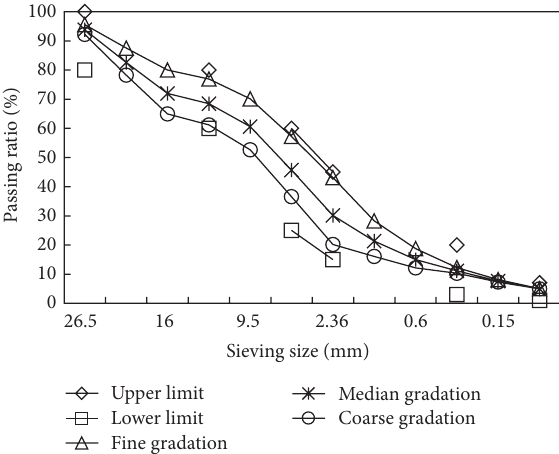
Figure 4: Different gradations used for cold recycled asphalt